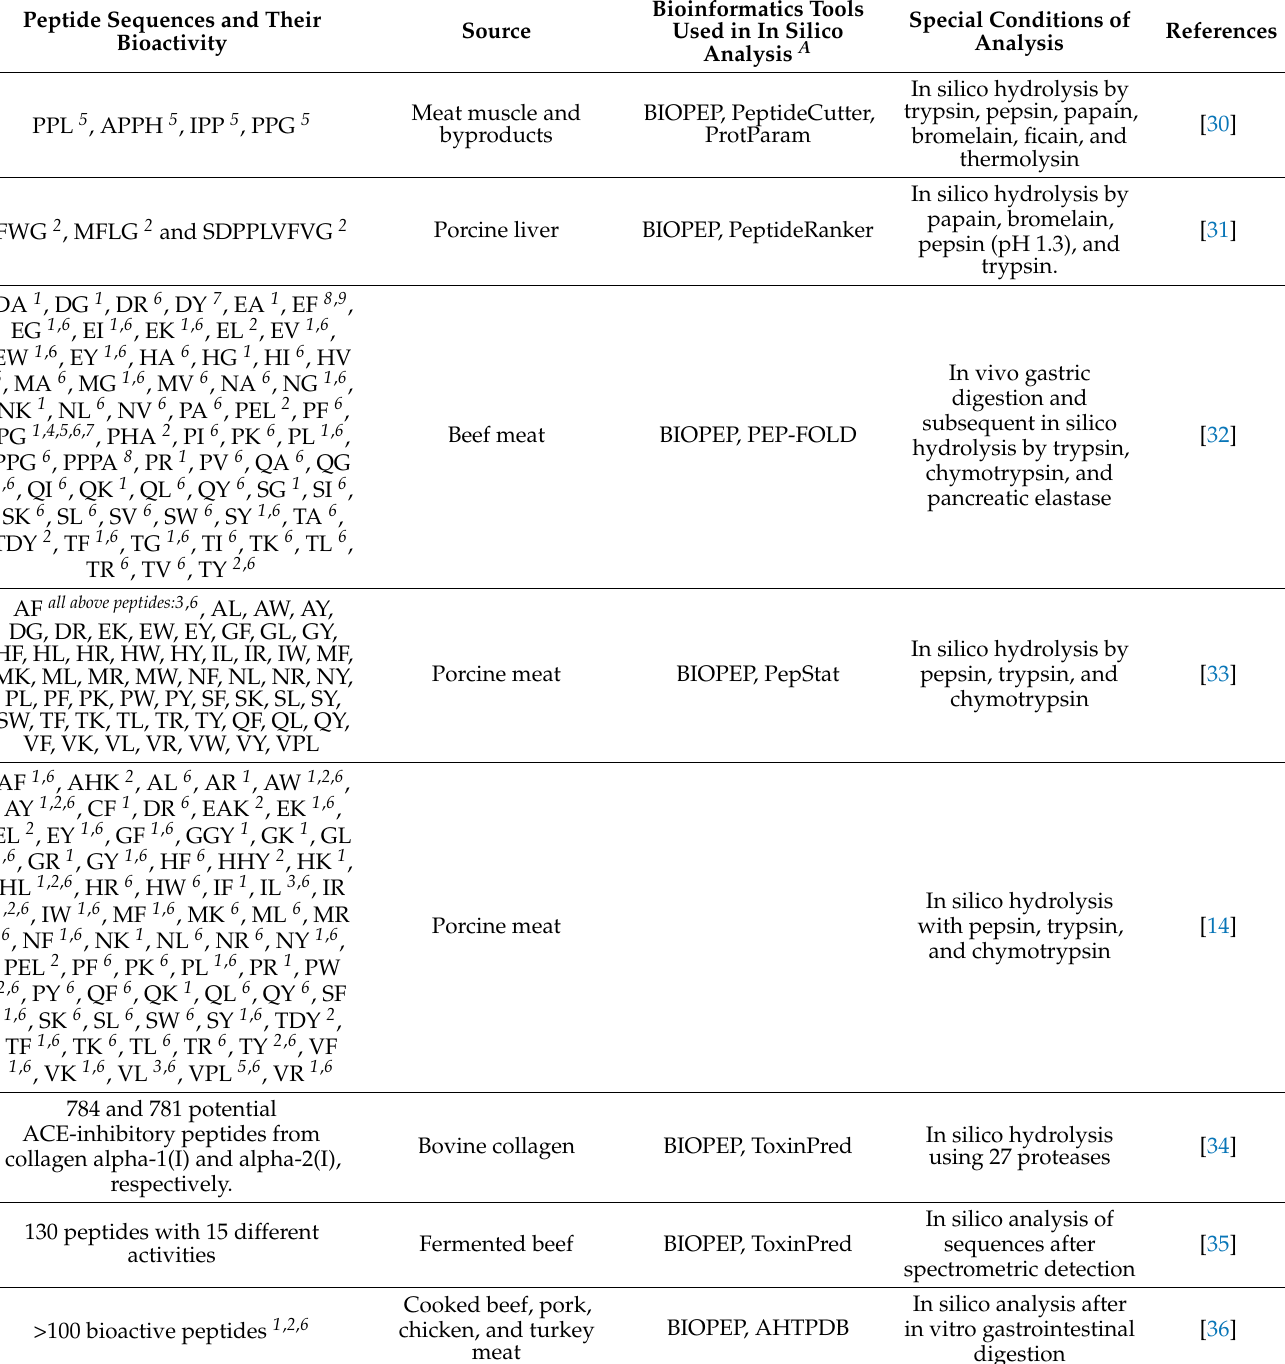
Table 1. Examples of bioactive peptides from meat and meat products discovered by in silico methods. Peptide Sequences and Their